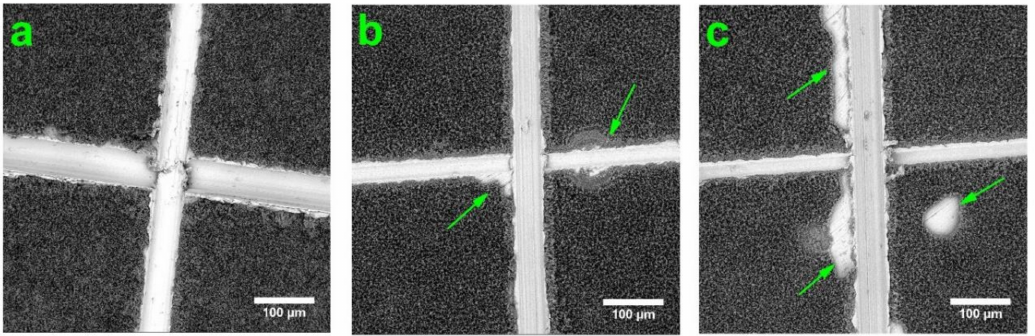
Figure 8. Representative SEM images of H ( a ), H-Mg1 ( b ), and H-Mg1.5 ( c ) coatings on Ti6Al4V substrate after the adhesion assay by the “tape test” (green arrow indicating the delaminated / a ff ected